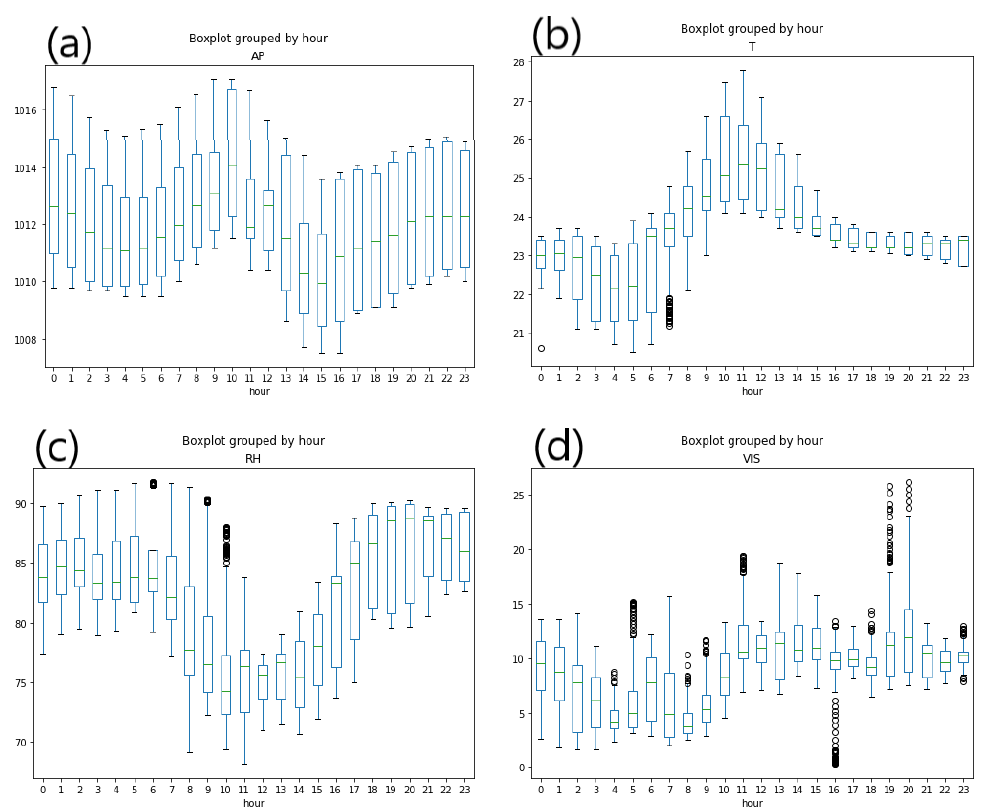
Figure 7. Boxplot of different features: ( a ) Hourly Air Pressure Statistics, ( b ) Hourly Temperature Statistics, ( c ) Hourly Relative Humidity Statistics, and ( d ) Hourly Visibility